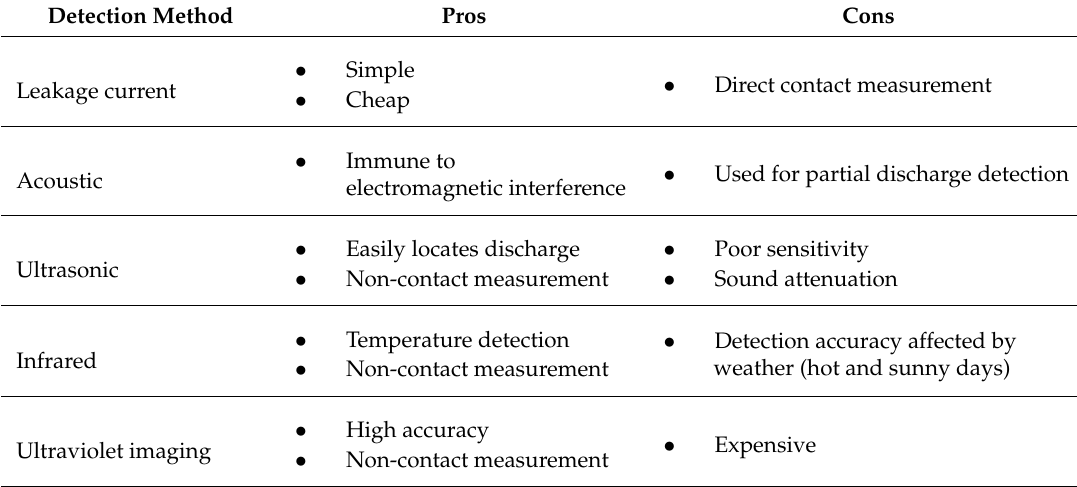
Table 1. Pros and cons of various detection